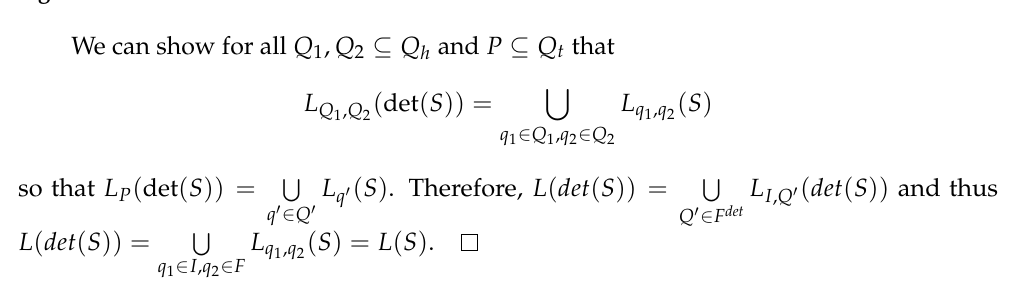
Figure 14. Determinization of SHA s.